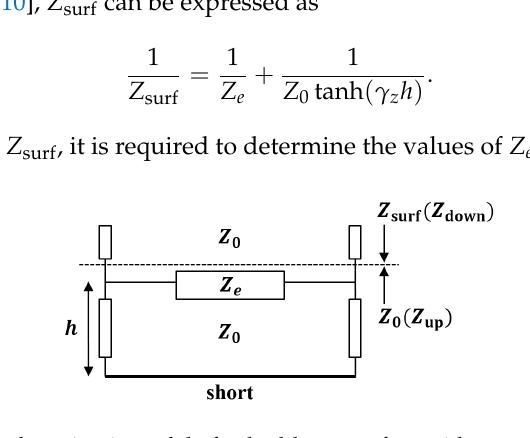
Figure 18. Equivalent circuit model of a dual-layer surface with ground plane at